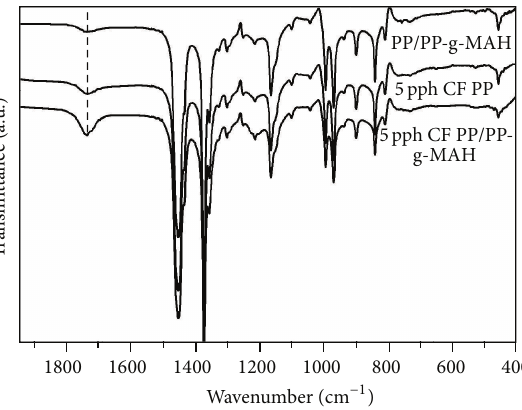
Figure 2: FTIR of the extruded samples.